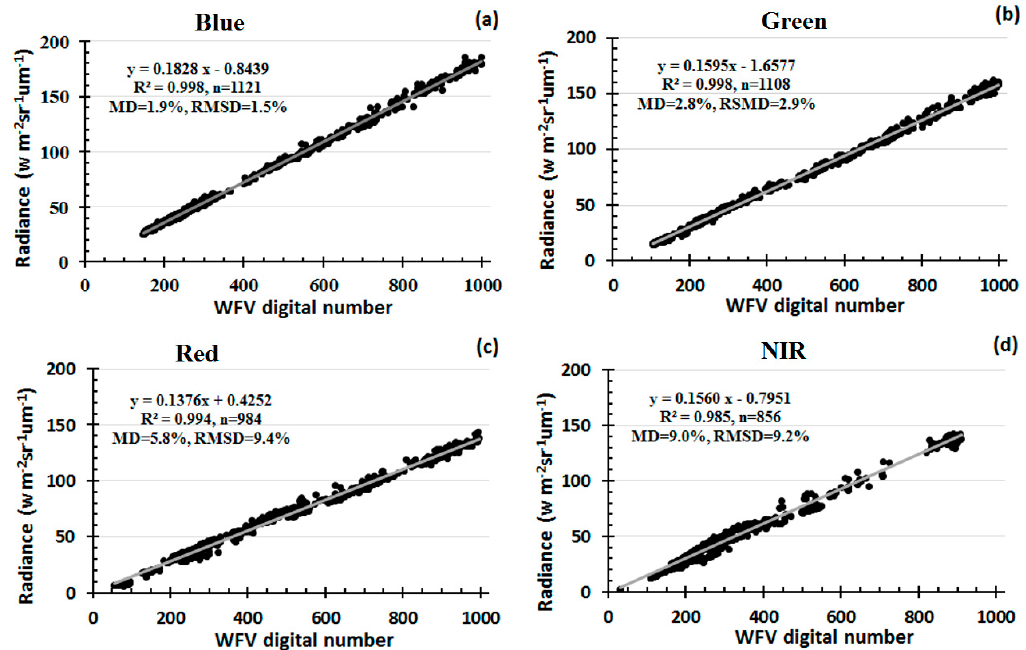
Figure 7. TOA radiance of selected calibration sites from Landsat-8 OLI plotted against the digital number of Gaofen-1 WFV3: ( a ) Blue band; ( b ) Green band; ( c ) Red band; and ( d ) NIR band. Linear fits between them resulted in cross calibration coefficients for the WFV instrument. Note that the RSR differences between the two sensors were adjusted.